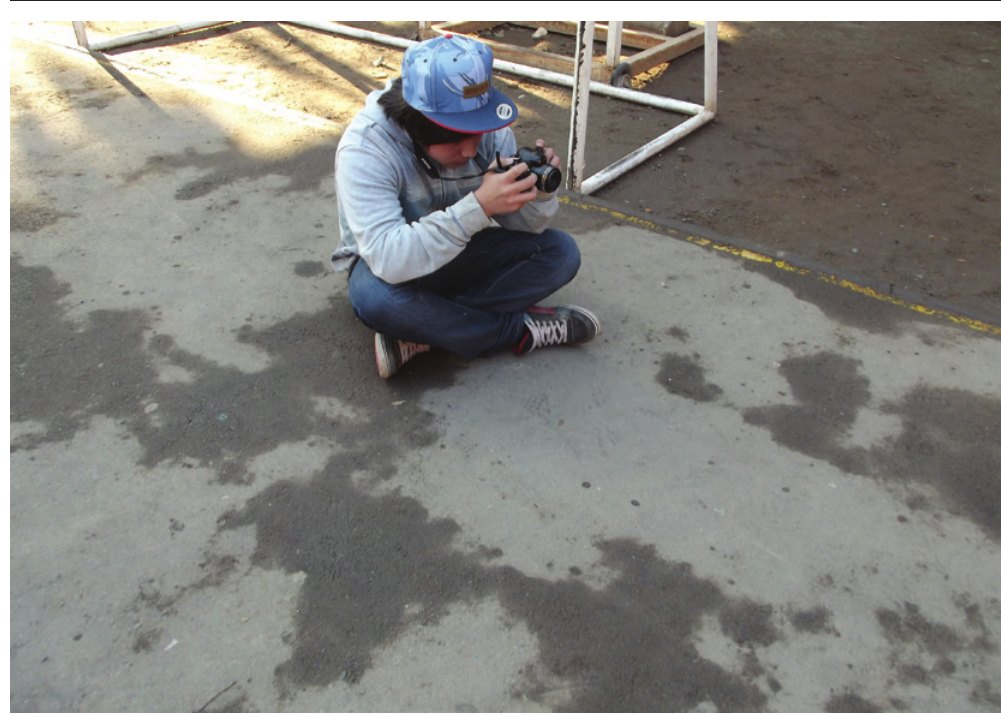
Figure 1: Photographing at